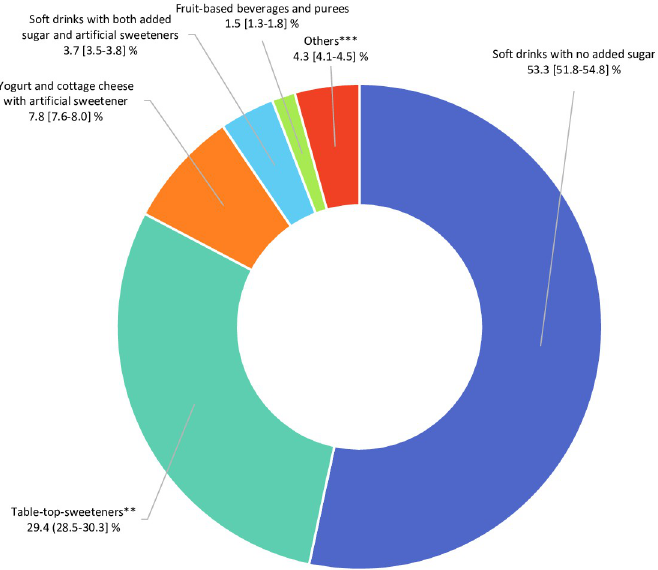
Fig 3. Relative contribution of each food group to the total intake of artificial sweeteners (percentage), NutriNet- Sante´, France, 2009–2021 ( n = 102,865). �� Artificial sweeteners used as tablets, liquid, or powder, added by the participants in yogurts, hot drinks, etc., or for cooking. ��� High-protein food substitutes, sugary foods, cookies, biscuits, cakes, pastries, breakfast cereals, sauces, savoury foods, and ultra-processed fish products.